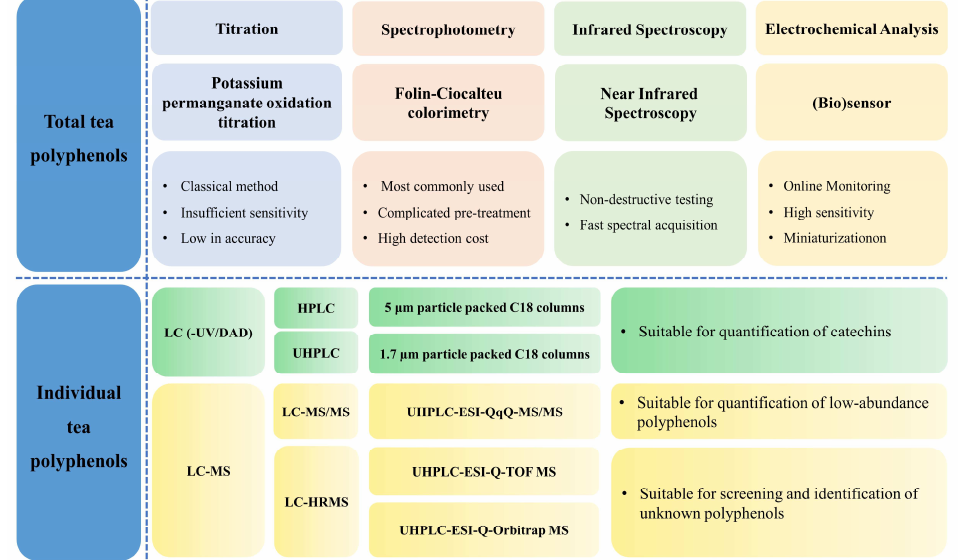
Figure 3. Summary of analytical methods for tea polyphenols (including representative applications and evaluations).